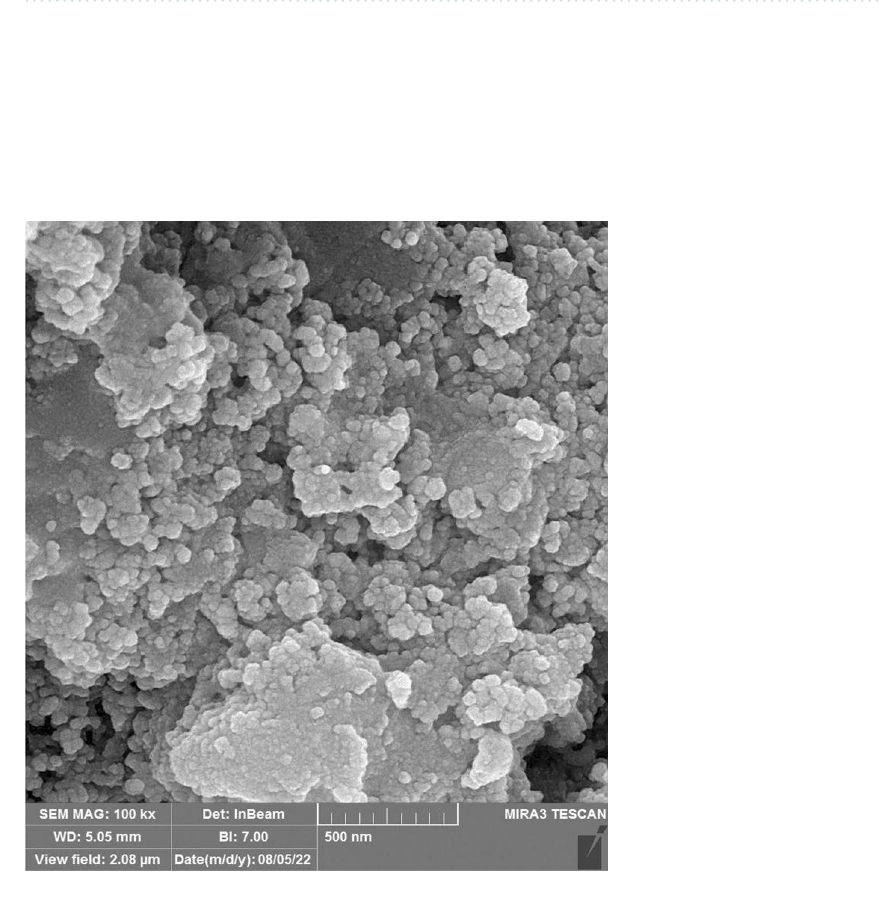
Figure 3. SEM image of silver